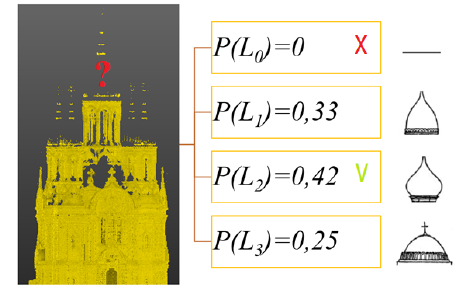
Figure 3: Process principles of developed